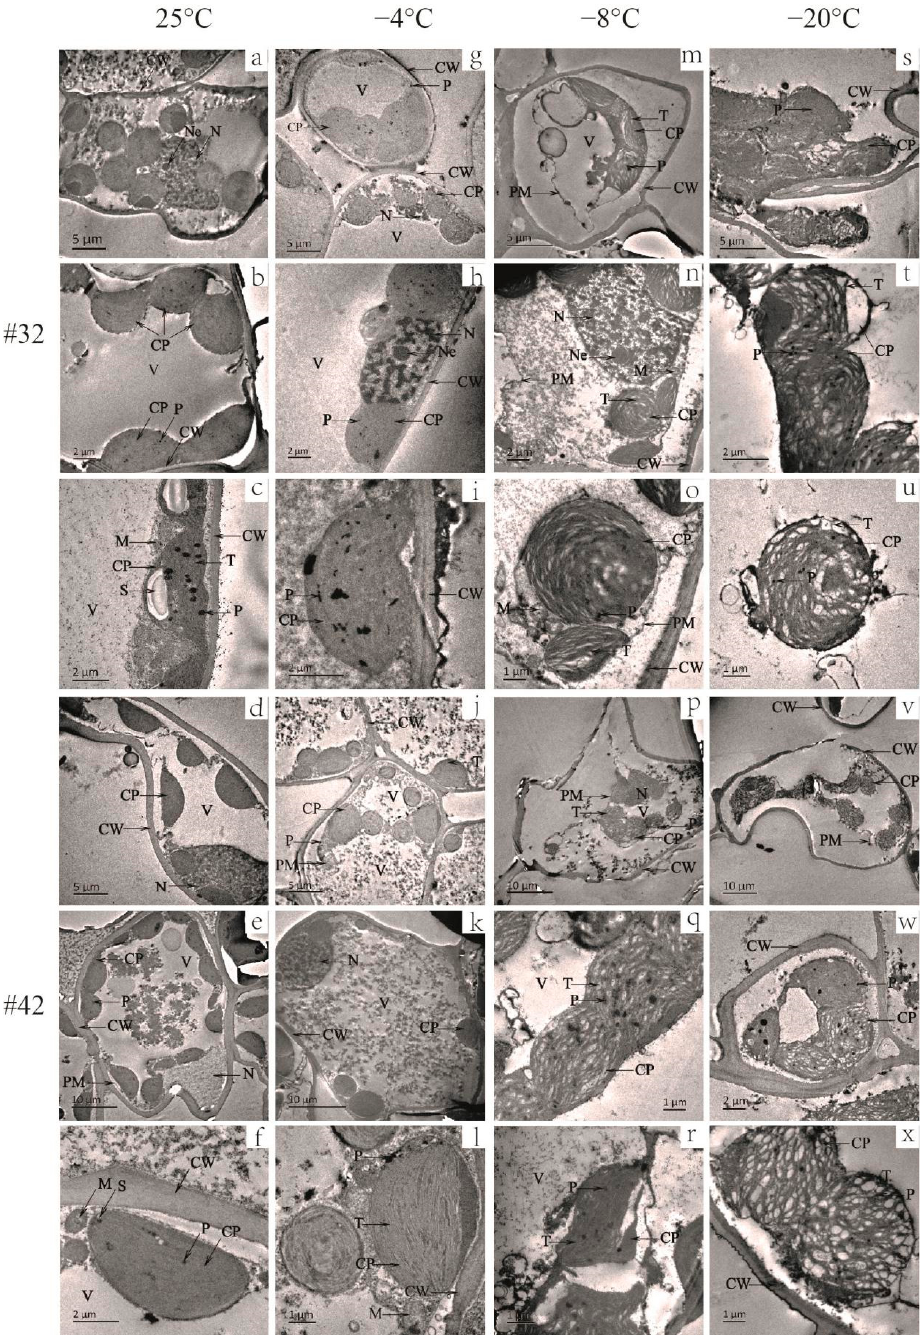
Figure 5. Ultrastructure of chloroplasts in #32 and #42 needles under decreasing low-temperature stress (LTS). These images of needles were taken from Advanced Analysis and Test Center in Nanjing Forestry University. ( a–c ) #32 at room temperature; ( d–f ) #42 at room temperature; ( g–i ) #32 at − 4 °C LTS; ( j–l ) #42 at − 4 °C LTS; ( m–o ) #32 at − 8 °C LTS; ( p–r ) #42 at − 8 °C LTS; ( s–u ) #32 at − 20 °C LTS; ( v–x ) #42 at − 20 °C LTS. CP: chloroplast; CW: cell wall; M: mitochondria; N: nucleus; Ne: nucleolus; P: plastoglobuli; PM: plasma membrane; S: starch granule; T: thylakoids; V: vacuole.